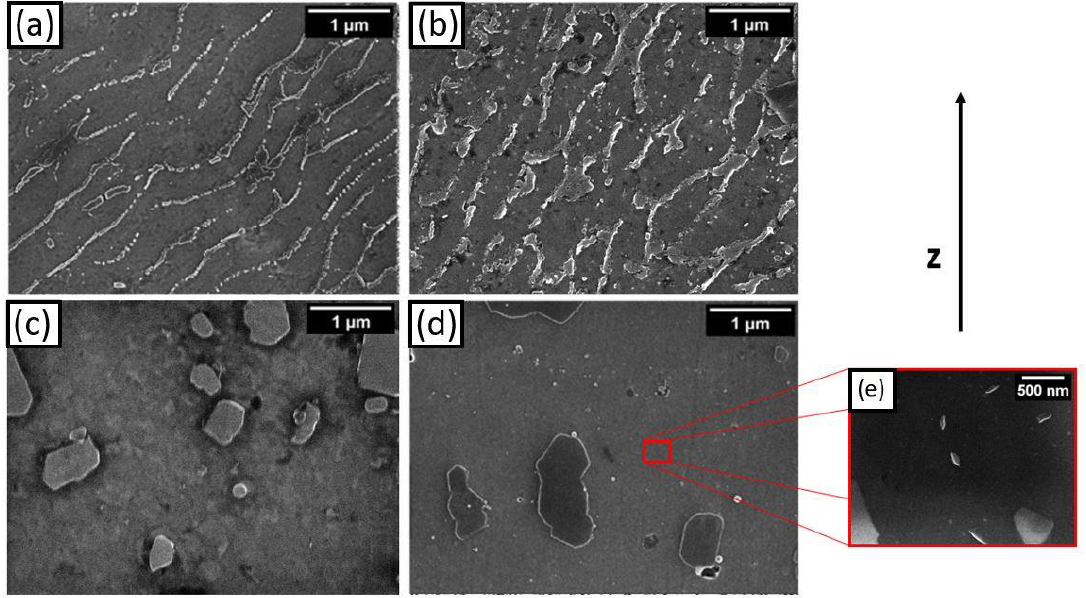
Figure 7. SEM micrographs at 60 k× for ( a ) AB, ( b ) DA-6, ( c ) S-SHT, ( d ) and S-T6-6 F357 samples, and at 100 k× for ( e ) small precipitates in the Al matrix.